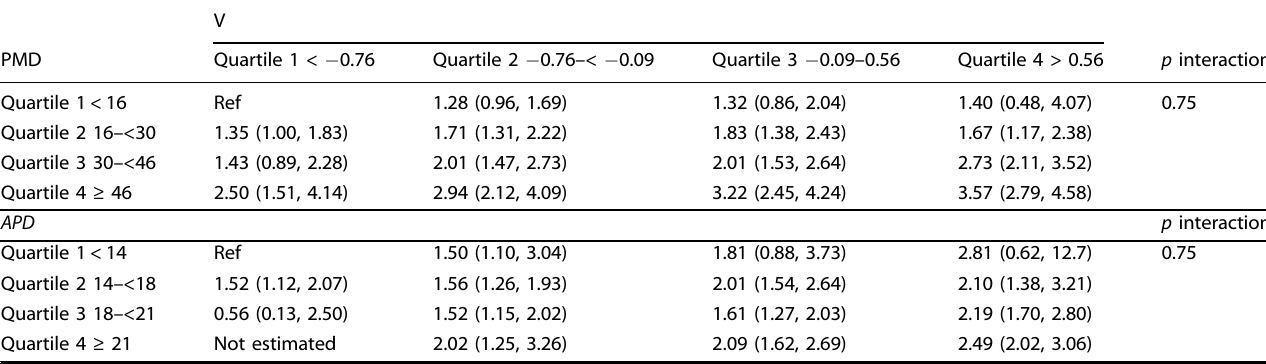
Table 3. ORs and 95% CIs for the associations between breast cancer risk and APD and PMD, cross-classi fi ed with V, in NHS/NHSII a .